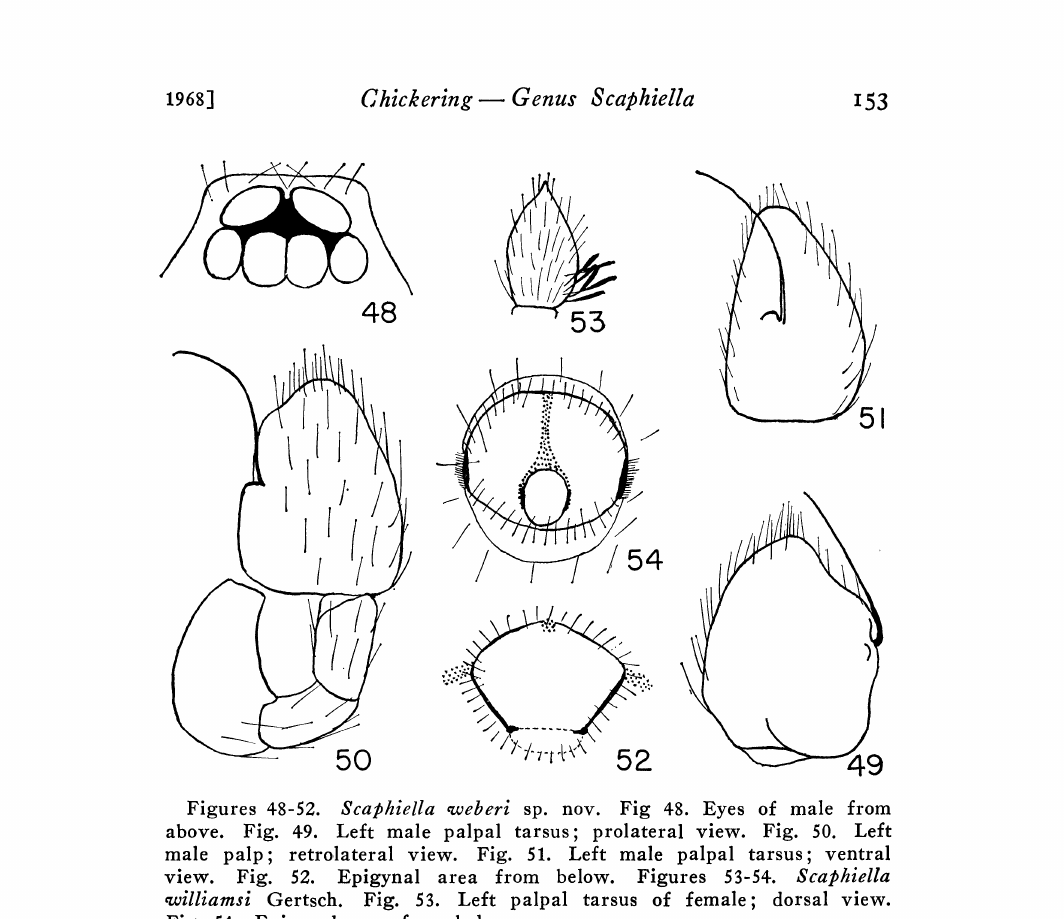
Figures 48-52. Scaphiella eberi sp. nov. Fig 48. Eyes of male from above. Fig. 49. Left male palpal tarsus; prolateral view. Fig. 50. Left male palp; retrolateral view. Fig. 51. Left male palpal tarsus; ventral view. Fig. 52. Epigynal area from below. Figures 53-54. Scaphiella illiamsi Gertsch. Fig. 53. Left palpal tarsus of female; dorsal view. Fig. 54. Epigynal area from